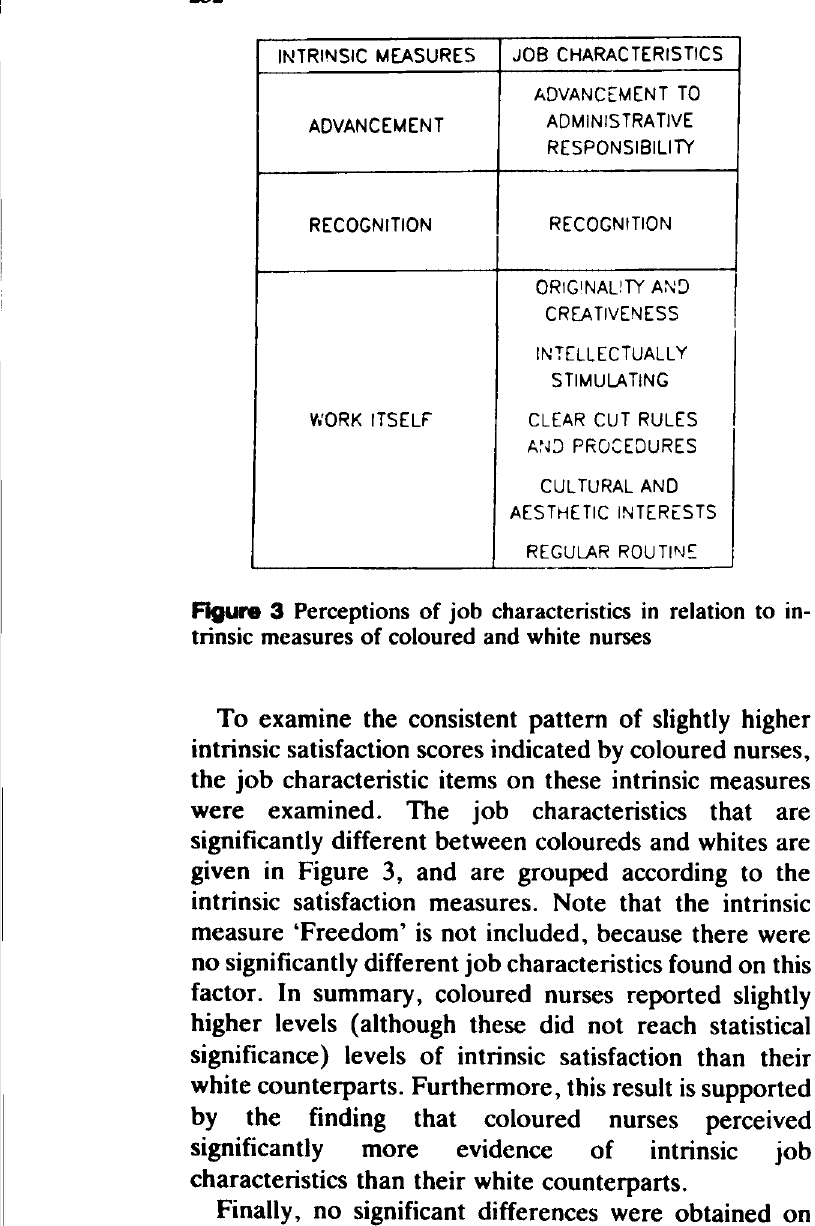
Figure 3 Perceptions of job characteristics in relation to in trinsic measures of coloured and white nurses To examine the consistent pattern of slightly higher intrinsic satisfaction scores indicated by coloured nurses, the job characteristic items on these intrinsic measures were